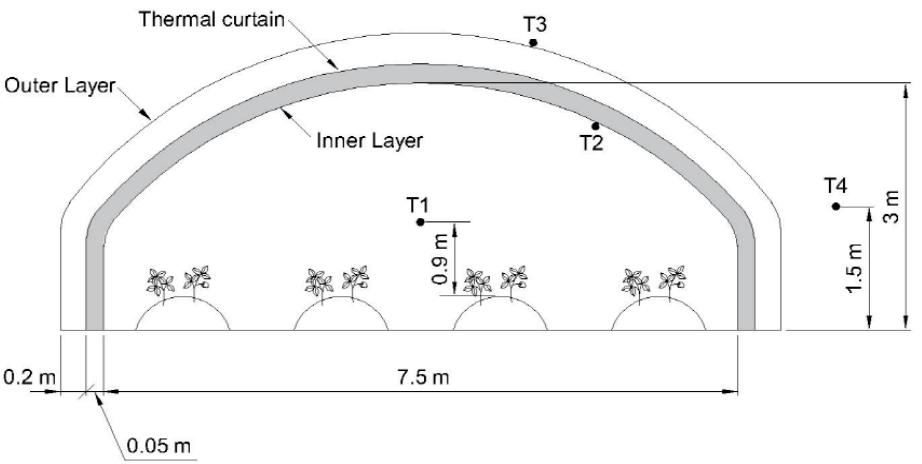
Figure 2. Schematic diagram of the experimental greenhouse with a thermal curtain: (T1) indoor air temperatures, (T2) inner cover surface temperatures, (T3) outer cover surface temperatures, and (T4) outdoor air temperatures.